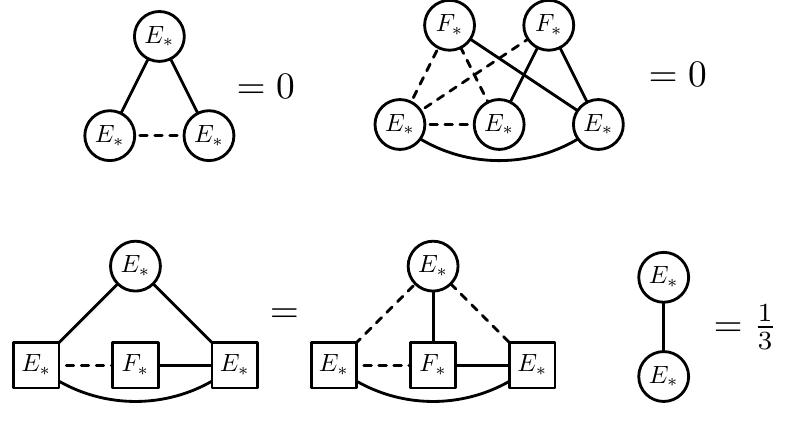
Figure 10: The decorated constraints forcing the structure of the composite tile E ∗ × E ∗